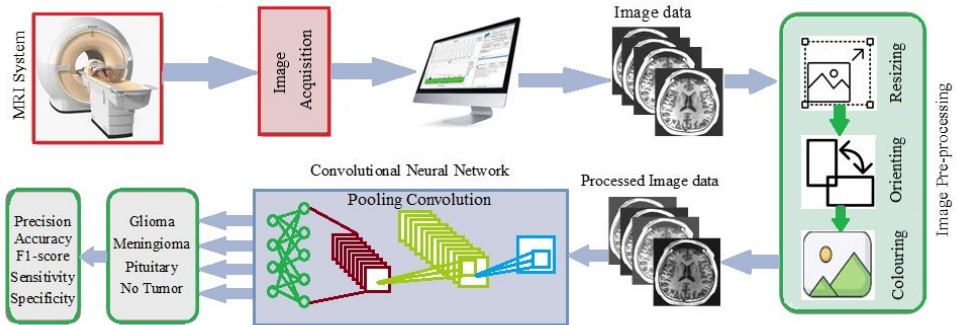
Figure 1. A high-level workflow diagram of the proposed method.